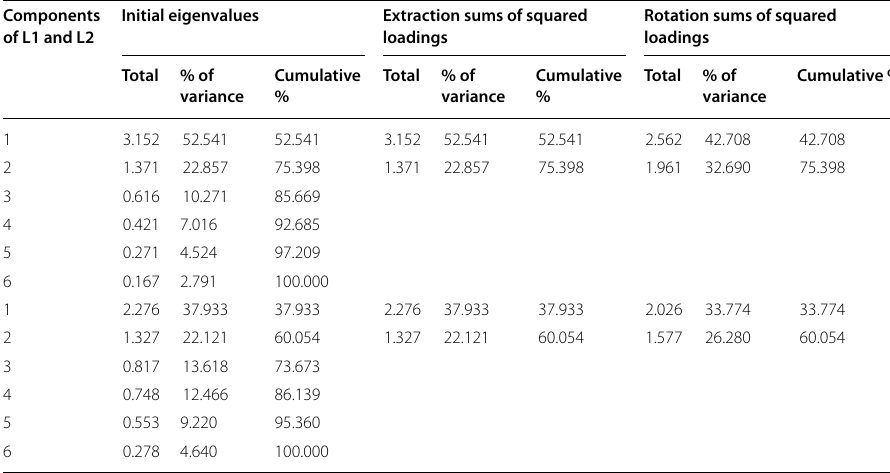
Table 10 Total variance explained for L1 and L2 Use with Others Components Initial eigenvalues of L1 and L2